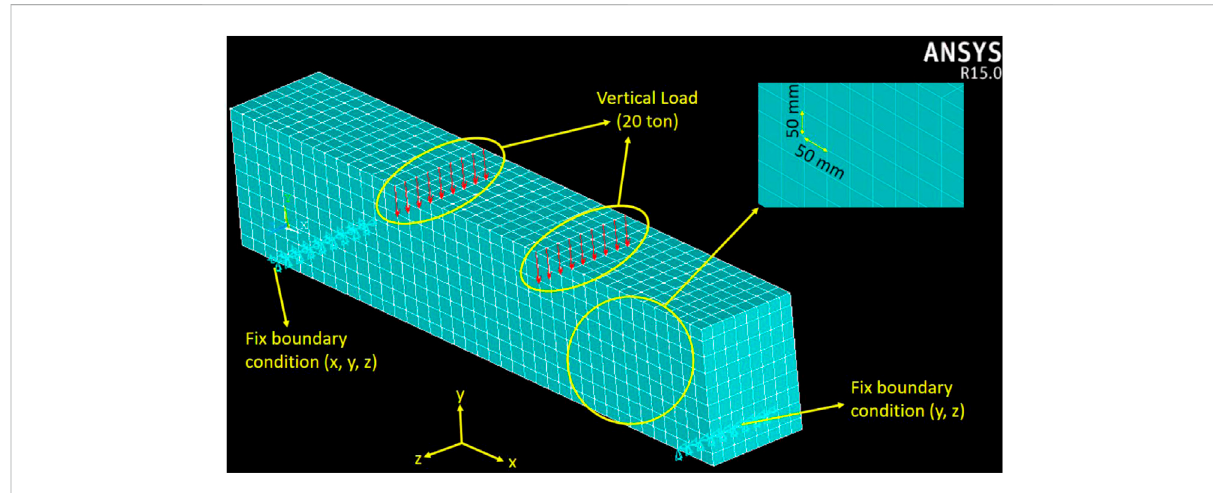
FIGURE 11 View of vertical loads and boundary conditions in the 3D model of RCB (Karalar,